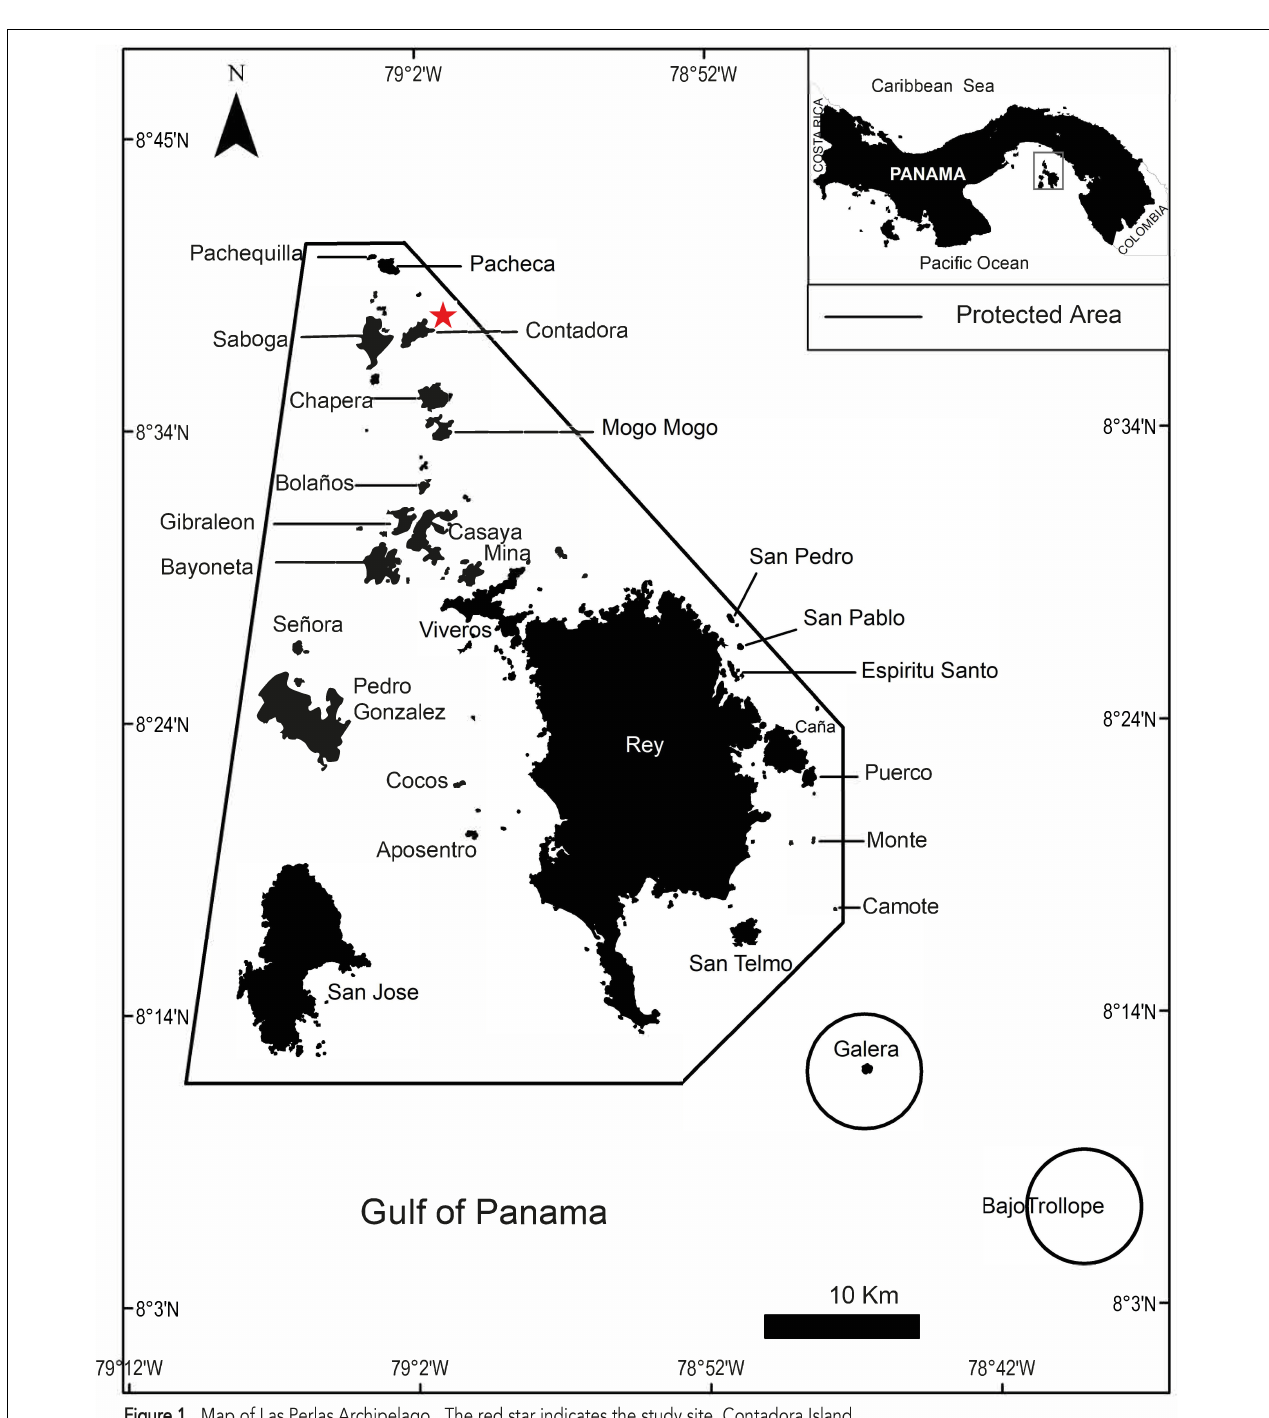
FIGURE 1 | Map of Las Perlas Archipelago. The red star indicates the study site, Contadora Island.